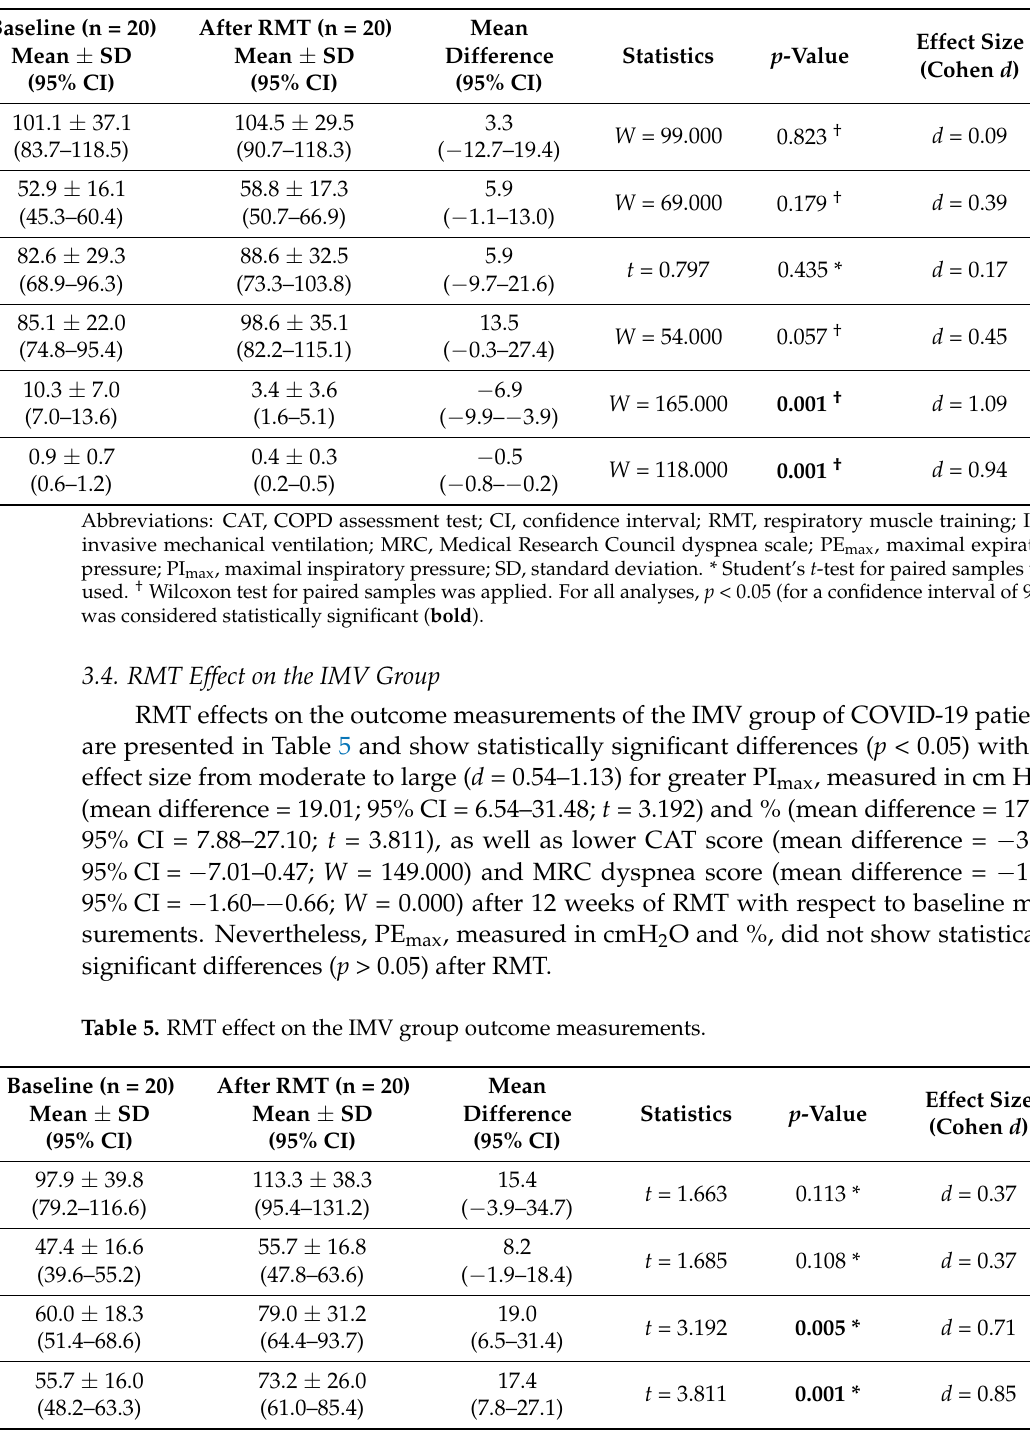
Table 4. RMT effect on the non-IMV group outcome measurements.